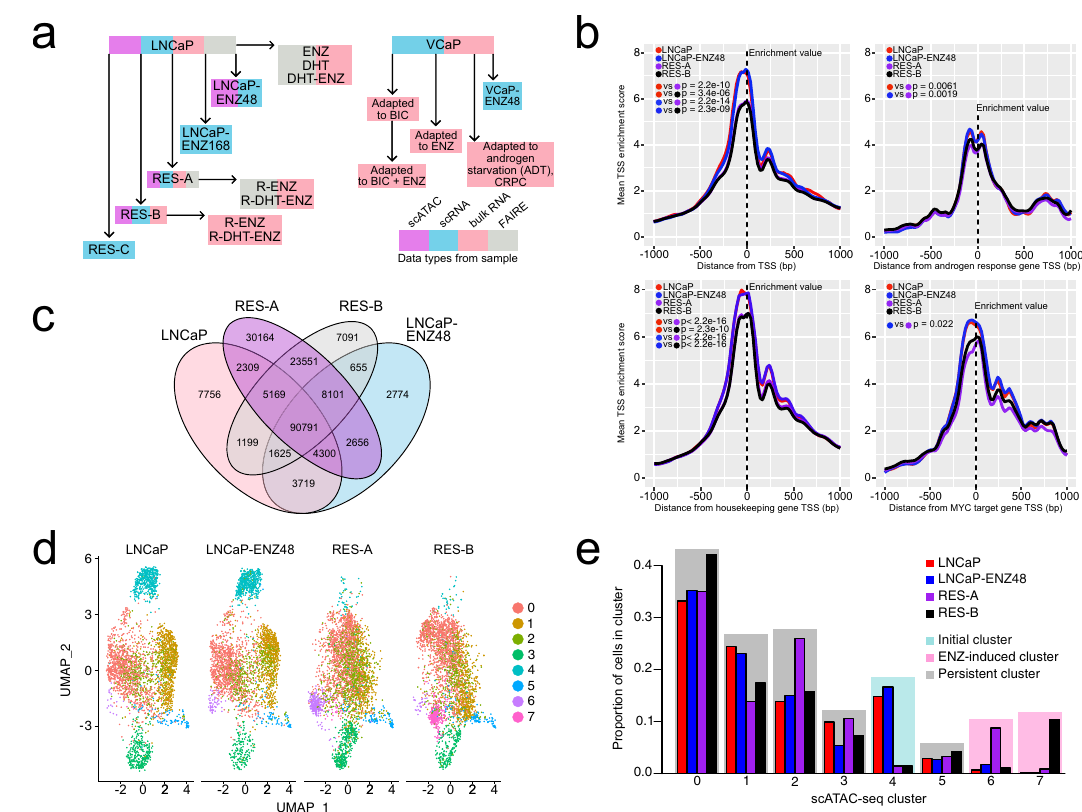
Fig. 1 Chromatin reprogramming in enzalutamide resistance. a Overview of the cell-line models, assays, and treatments included in the study. Boxes with sample names are colored according to the data types generated from the sample (single-cell (sc) assay for transposase-accessible chromatin (ATAC)-, scRNA-, bulk RNA- and/or formaldehyde-assisted isolation of regulatory element (FAIRE) sequencing). b Smoothed line plots of LNCaP parental, LNCaP – ENZ48, RES-A, and RES-B scATAC-seq enrichment scores in a 2-kb window around the transcription-start sites (TSS) of 5000 randomly selected genes, housekeeping genes, androgen response genes (MSigDB), and MYC target genes (MSigDB). Enrichment scores at each TSS (position 0 in the plot marked with a black dashed line) were used as the enrichment values and compared between pairs of samples. Sample comparisons are indicated using colored dots and the two-sided Wilcoxon rank-sum p -values are shown within the plots. c Venn diagram of shared and unique chromatin regions in LNCaP parental, LNCaP-ENZ48, RES-A, and RES-B based on a bulk analysis of scATAC-seq. d Uniform manifold approximation and projection (UMAP) scATAC- seq clustering visualization of LNCaP parental, LNCaP – ENZ48, RES-A, and RES-B. e Proportions of cells in the scATAC-seq clusters. Clusters are colored according to cluster type: initial (most prevalent in LNCaP parental and LNCaP – ENZ48), ENZ-induced (most prevalent in RES-A or RES-B), or persistent (present at similar proportions in all samples). ENZ = enzalutamide, DHT = dihydrotestosterone, BIC = bicalutamide, CRPC = castration-resistant prostate cancer. See also Supplementary Fig. Overall, these data show extensive chromatin reprogramming during the emergence of resistance to AR-targeting agents.